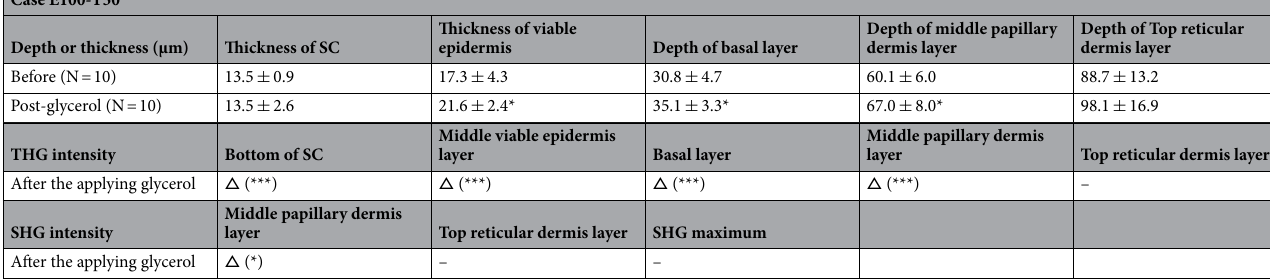
Table 4. Variation of skin structure, THG intensity, and SHG intensity after 100% glycerol topical application for 30 min. −: no significant difference, △ : Increased significantly, ▽ : Decreased significantly, * P < 0.05, ** P < 0.01, *** P < 0.001.